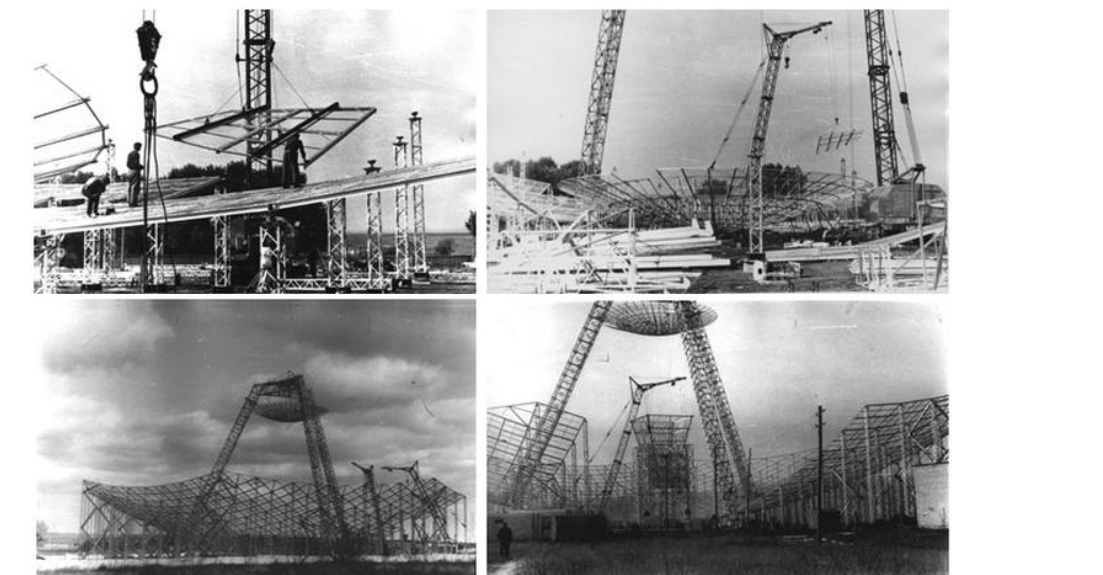
Figure 3. Construction stages of the 100-m-diameter parabolic antenna.